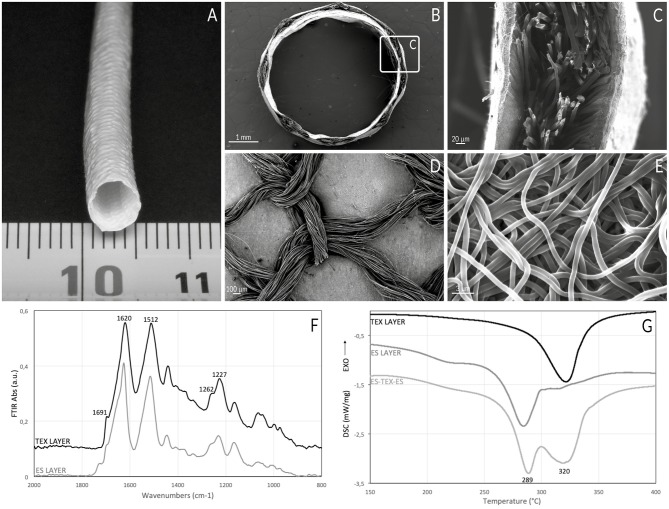
Morphological and physico-chemical structure of SilkGraft. (A) Picture of a SilkGraft device with 5 mm nominal inner diameter (ruler in mm). (B) SEM cross-section of the graft showing the two inner and outer ES layers that enclose the intermediate TEX layer (scale bar, 1 mm). (C) Detail of (B) showing a magnification of the wall structure (scale bar 20 μm). (D) TEX layer coupled to an ES layer, visible in the background. The texture of the braided mesh is characterized by the presence of voids (scale bar 100 μm). (E) SEM detail of SF nanofibers of the ES layer (scale bar, 3 μm). (F) ATR-FTIR spectra of TEX and ES layers in the 2,000–800 cm−1 range. (G) DSC thermograms of TEX layer, ES layer, and SilkGraft finished device (marked ES-TEX-ES) in the 150–400°C temperature range.